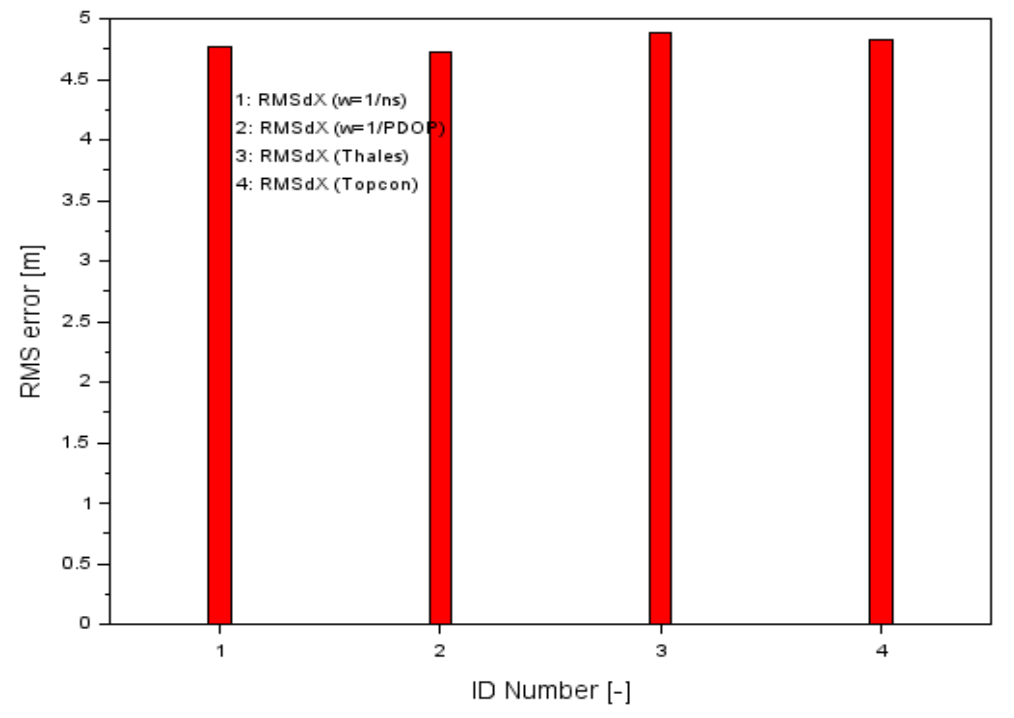
Figure 7. Comparison of RMS errors along the X-axis.